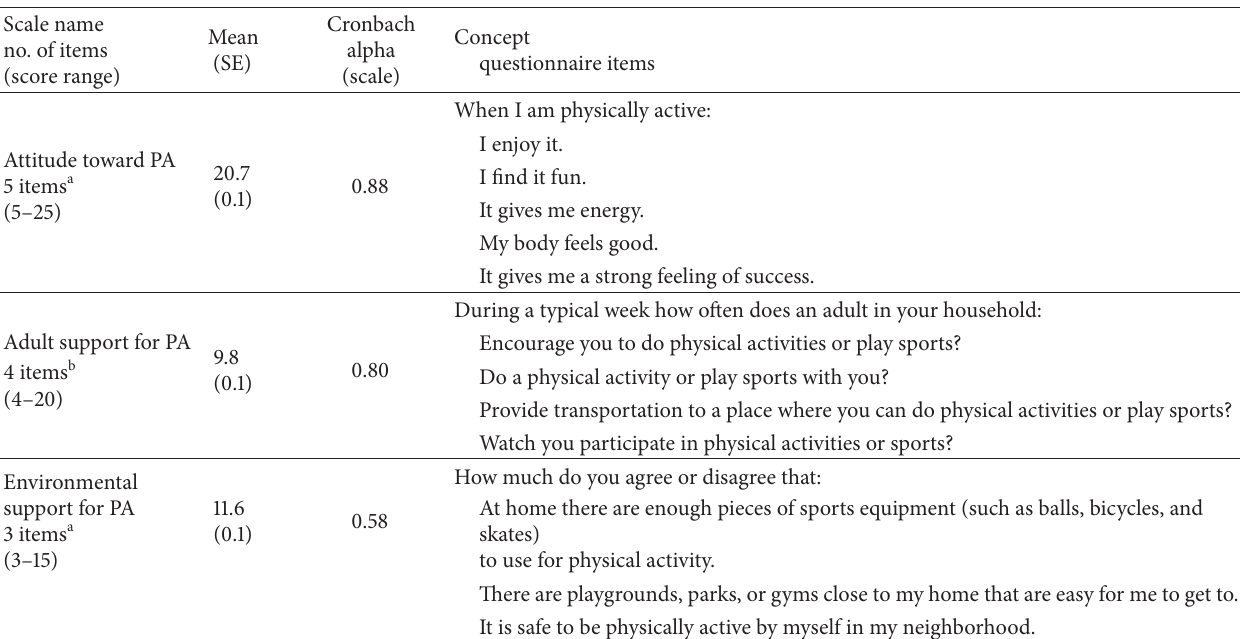
Table 1: Psychometric properties of scales used to measure correlates of physical activity (PA), including personal attitude, adult support, and environmental support among US high school